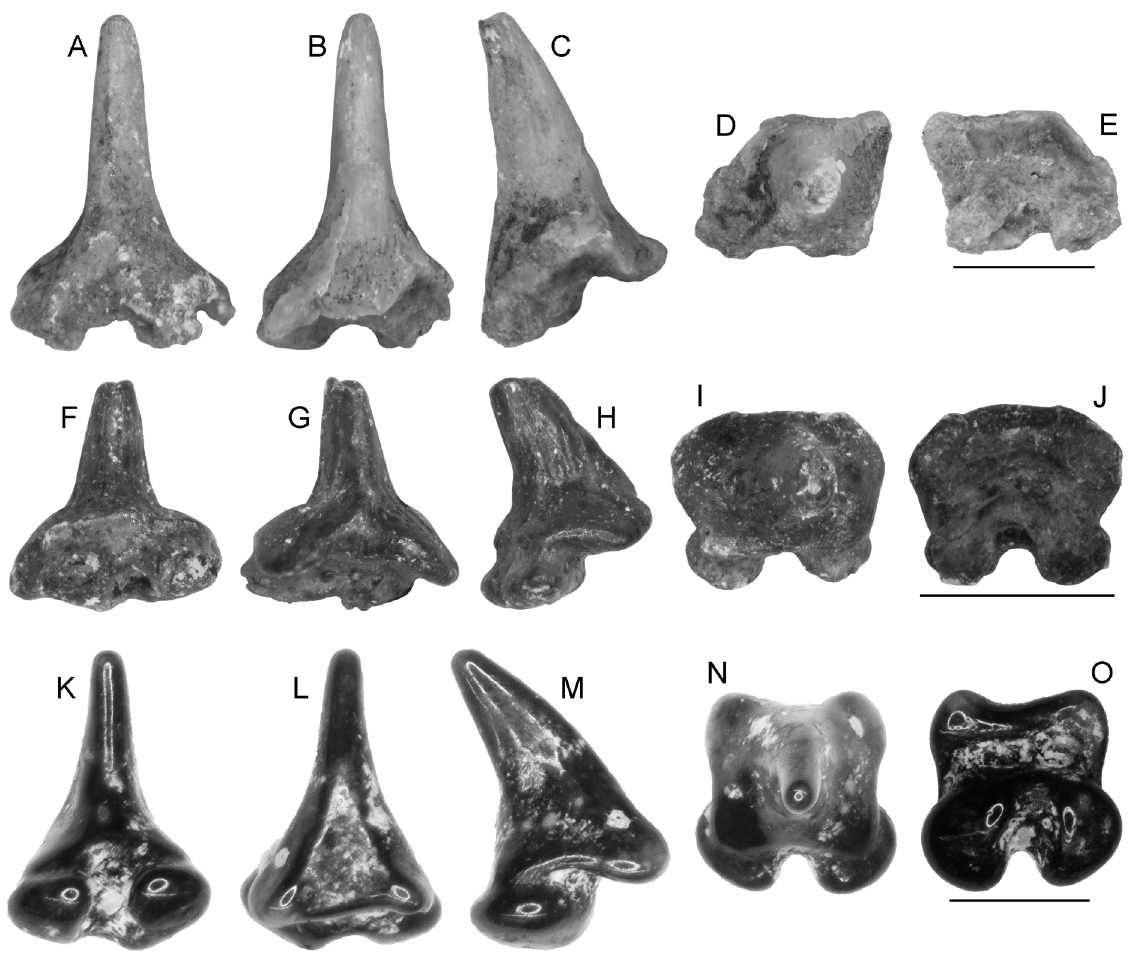
Fig. 55. Batomorphii indet., teeth. A–E . MSC 37675.2, basal Lisbon Formation. A . Labial